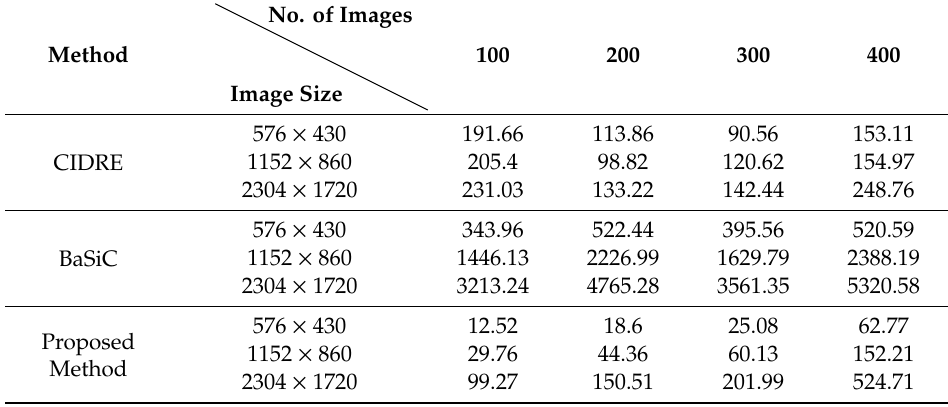
Table 2. Processing time (s) according to image size and number of